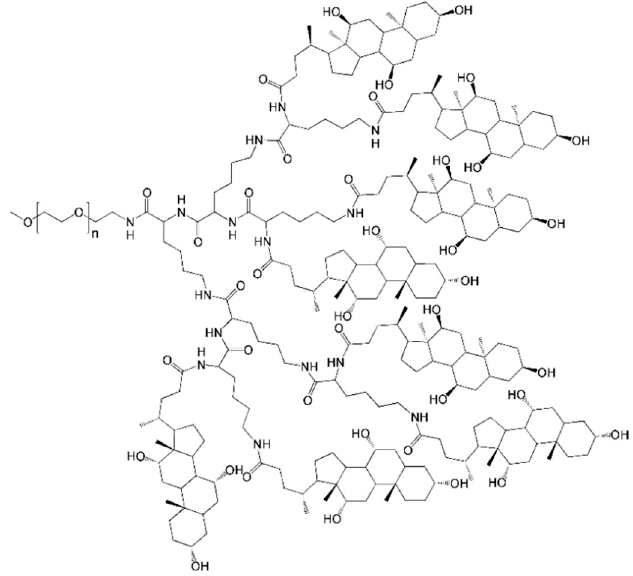
Figure 3. The basic outline of a PEG-poly(lysine) telodendrimer functionalized with cholic acid on both the α and ε amines of the lysine moieties.